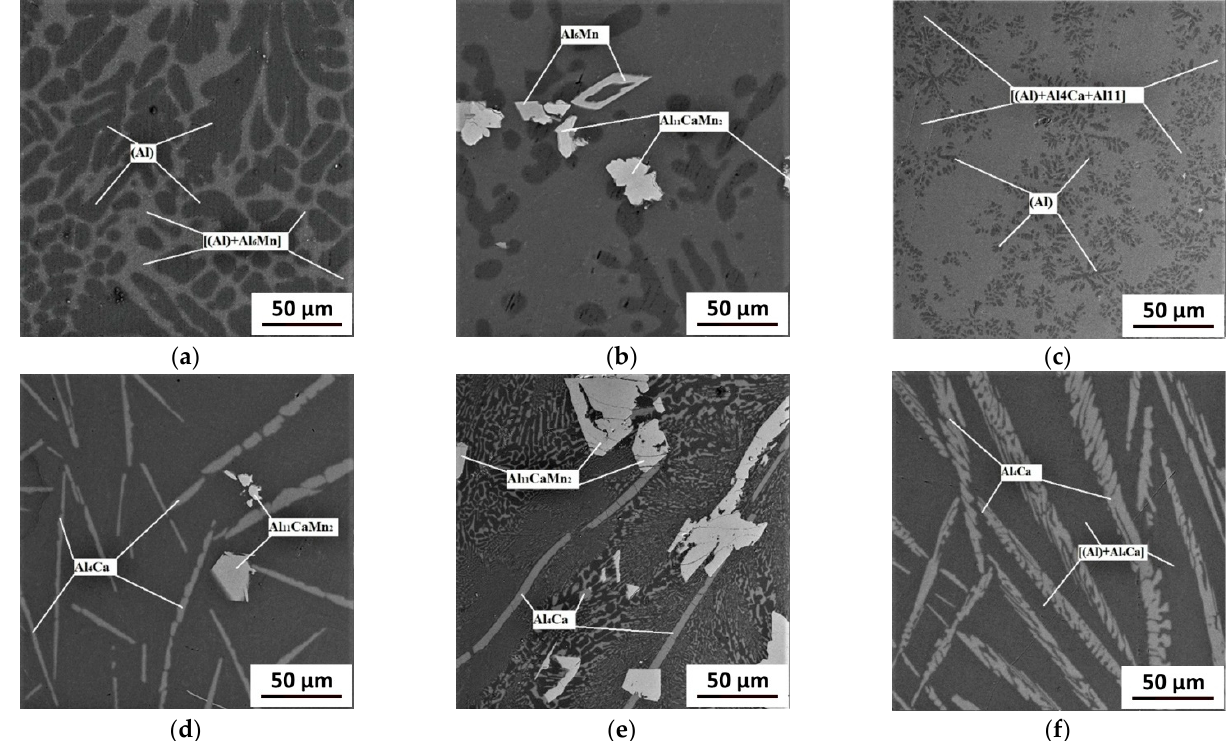
Figure 3. SEM images showing the microstructure of the experimental Al-Ca-Mn alloys in the as-cast condition: ( a ) Al-3Ca-2Mn; ( b ) Al-6Ca-1.5Mn; ( c ) Al-8Ca-0.5Mn; ( d ) Al-10Ca-1.5Mn; ( e ) Al-10Ca-2.5Mn; ( f ) Al-10Ca.